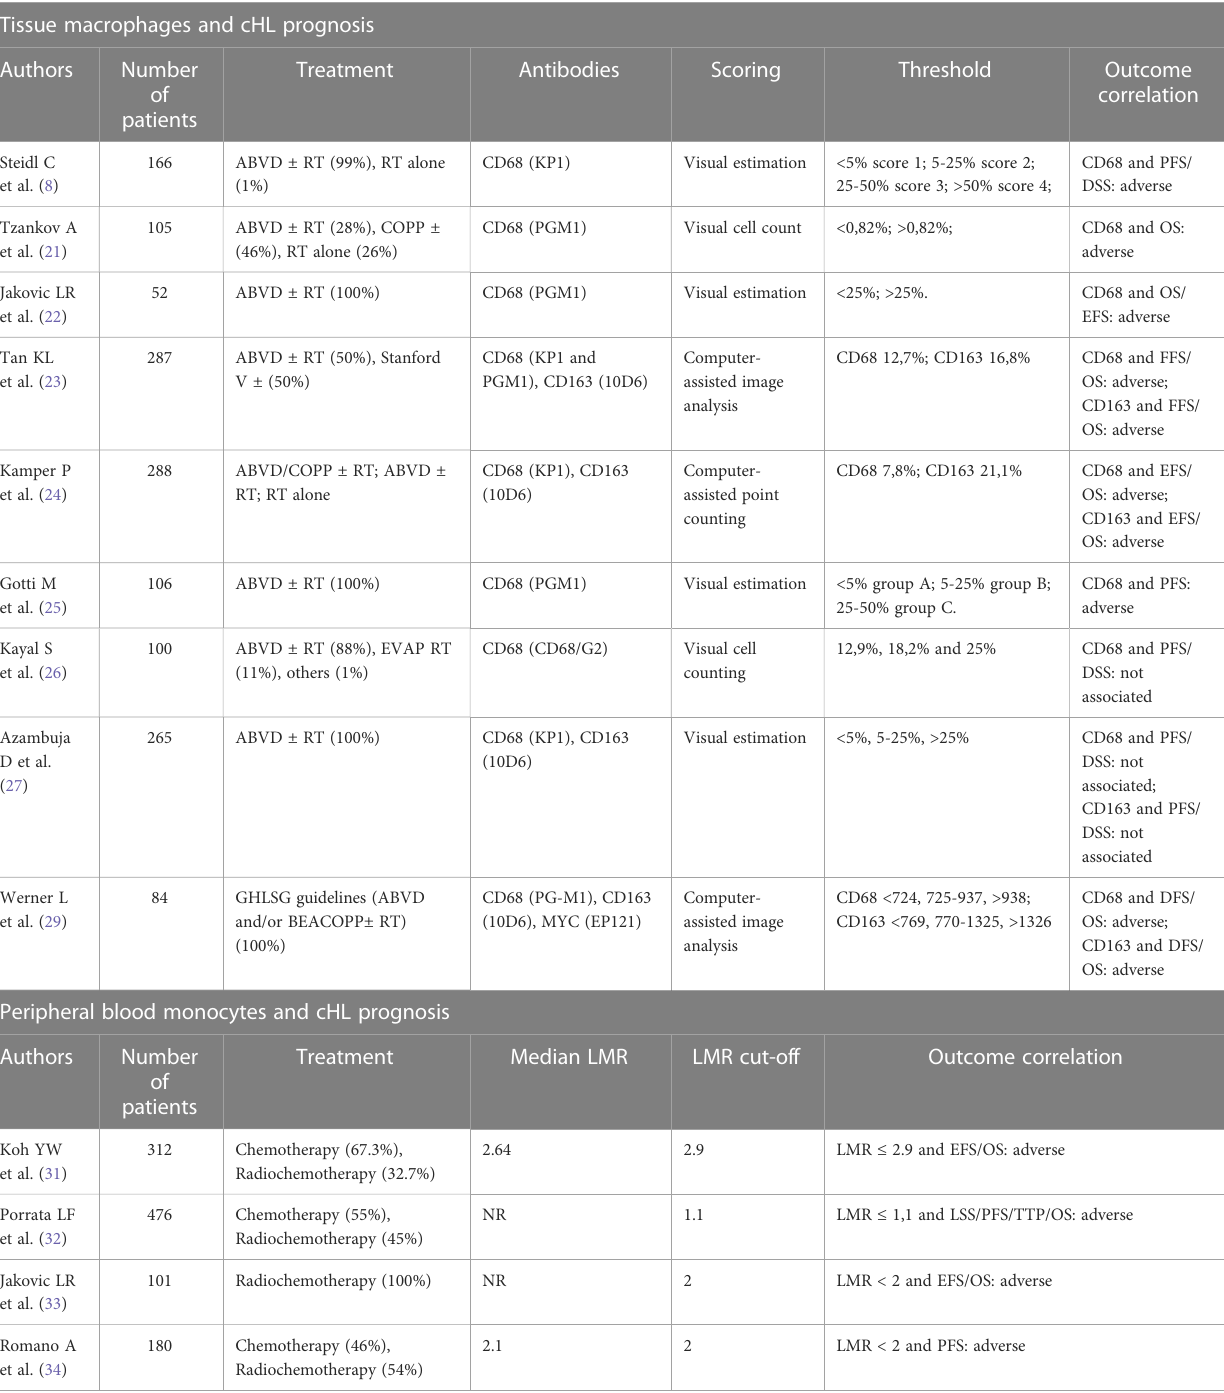
TABLE 1 Prognostic impact of tissue macrophages and circulating monocytes in